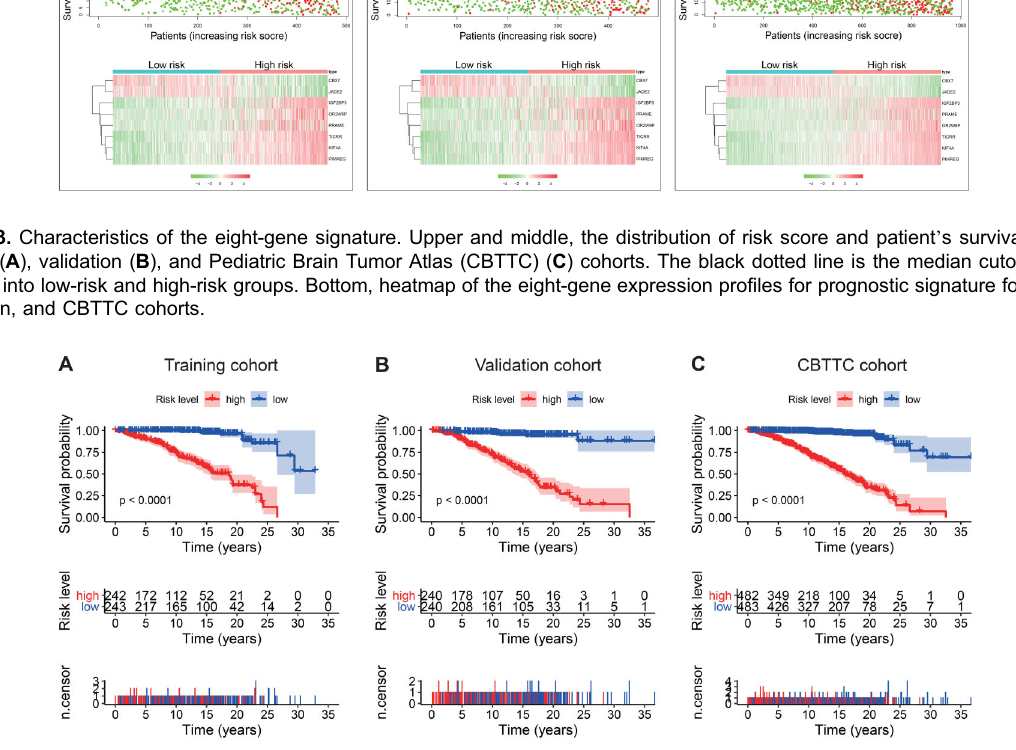
Figure 4 . Kaplan-Meier analyses of the overall survival based on the eight-gene signature. A , Training cohort. B , Validation cohort. C , Pediatric Brain Tumor Atlas (CBTTC) cohort. The differences between the two curves were determined by the two-side log-rank test. The number of patients at risk are listed in the middle plot of each